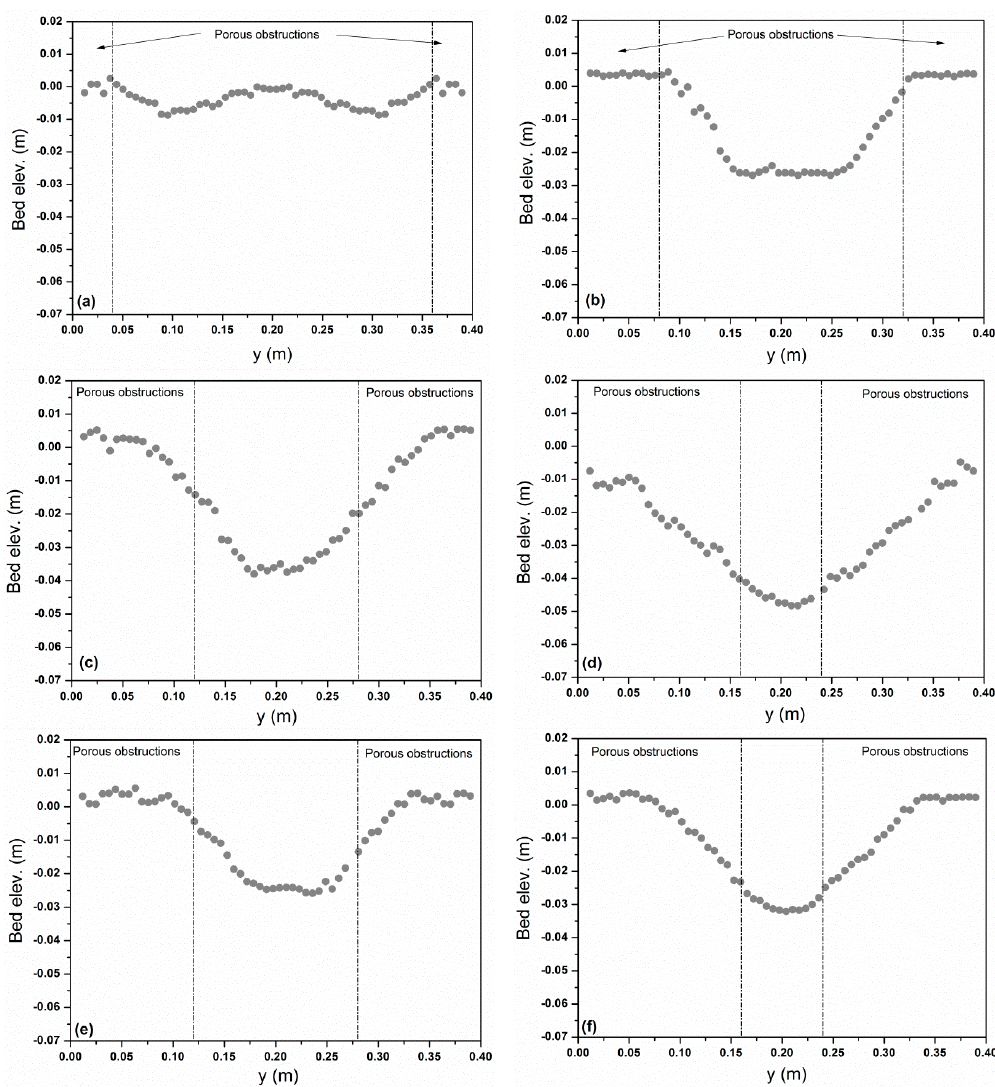
Figure 5. Lateral bed profiles at x = 2.55 m: ( a ) 2 aW v / W = 5.0 ( h / h p = 1.0; Exp No. 2); ( b ) 2 aW v / W = 10.0 ( h / h p = 1.0; Exp No. 4); ( c ) 2 aW v / W = 15.0 ( h / h p = 1.0; Exp No. 7); ( d ) 2 aW v / W = 20.0 ( h / h p = 1.0; Exp No. 12); ( e ) 2 aW v / W = 15.0 ( h / h p = 1.6; Exp No. 16); ( f ) 2 aW v / W = 20.0 ( h / h p = 1.6; Exp No. 20).